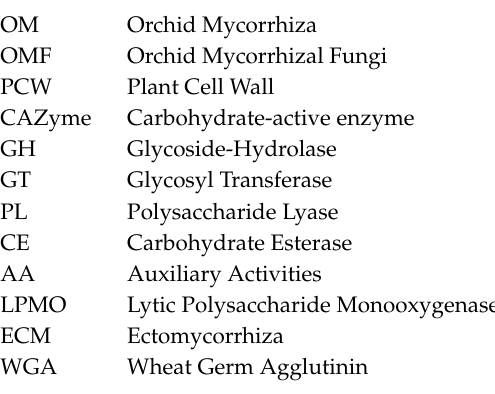
Table S1, Species and experimental conditions of RNA-seq studies considered for gene expression meta-analysis. Table S2, Reads number and mapping details of selected RNA-seq libraries from short read archive (SRA). Table S3, Reference JGI fungal transcriptomes used for mapping. Table S4, Selected primers used in RT-qPCR